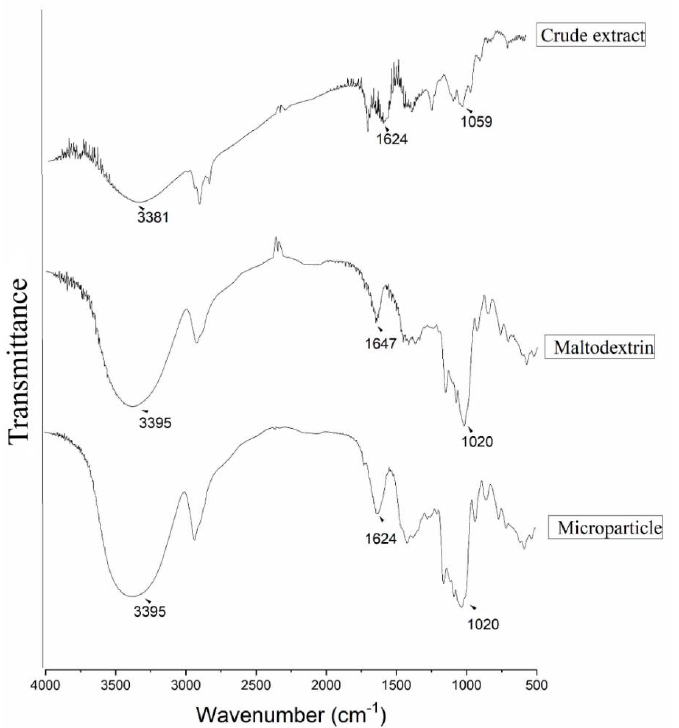
Figure 5. FTIR spectra of the crude extract, maltodextrin adjuvant and microparticle in the absorption range of 4000 to 600 cm − 1 , with 32 scans and 4 cm − 1 resolution .